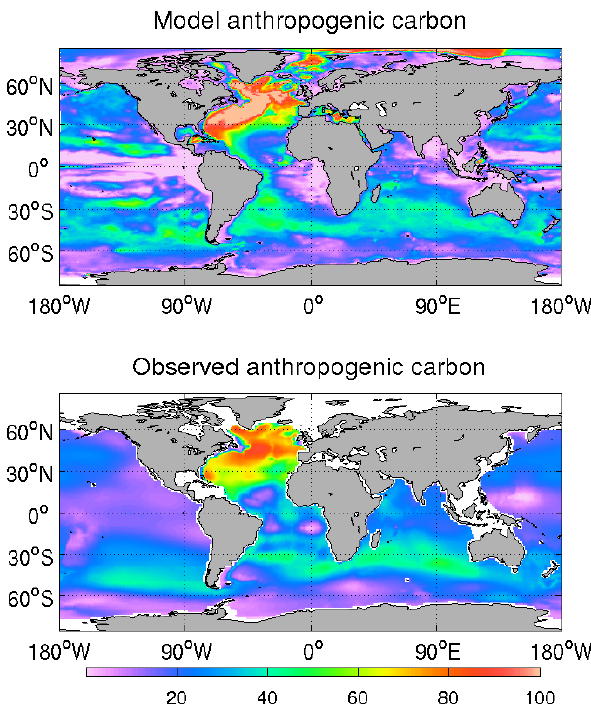
Fig. 14. Maps of approximation of anthropogenic carbon inventory for the 1994 period as estimated by the model (top) together with the observational based estimates (bottom) of Key et al. (2004). Units are in (molCm − 2